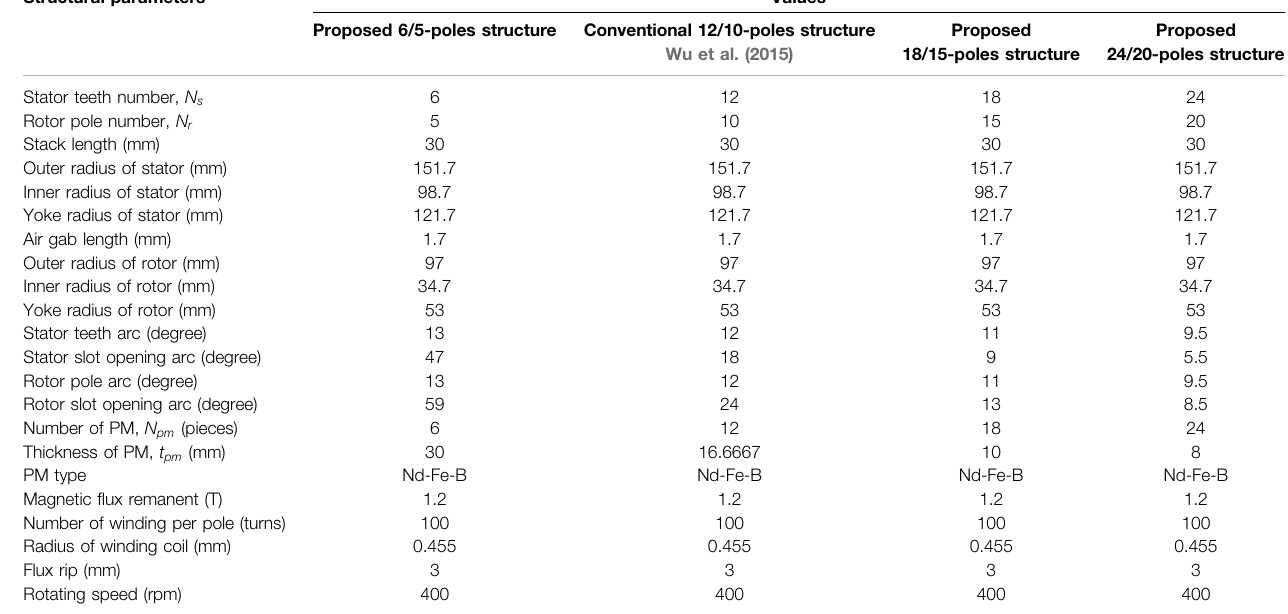
TABLE 1 | The structural design parameters of all proposed DSPM. Structural